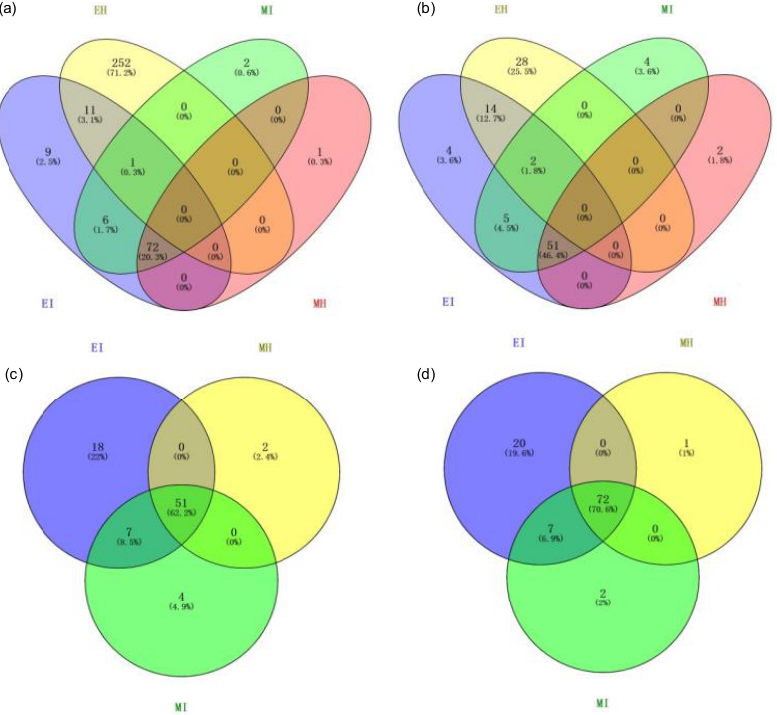
Figure 7. Edge and node discrepancies between the four gut microbiome networks. ( a , c ): node discrepancies among the four gut microbiome networks; ( b , d ): edge discrepancies among the four gut microbiome networks. (EH: emergence period, healthy; EI: emergence period, infested; MH: mating period, healthy; MI: mating period, infested).